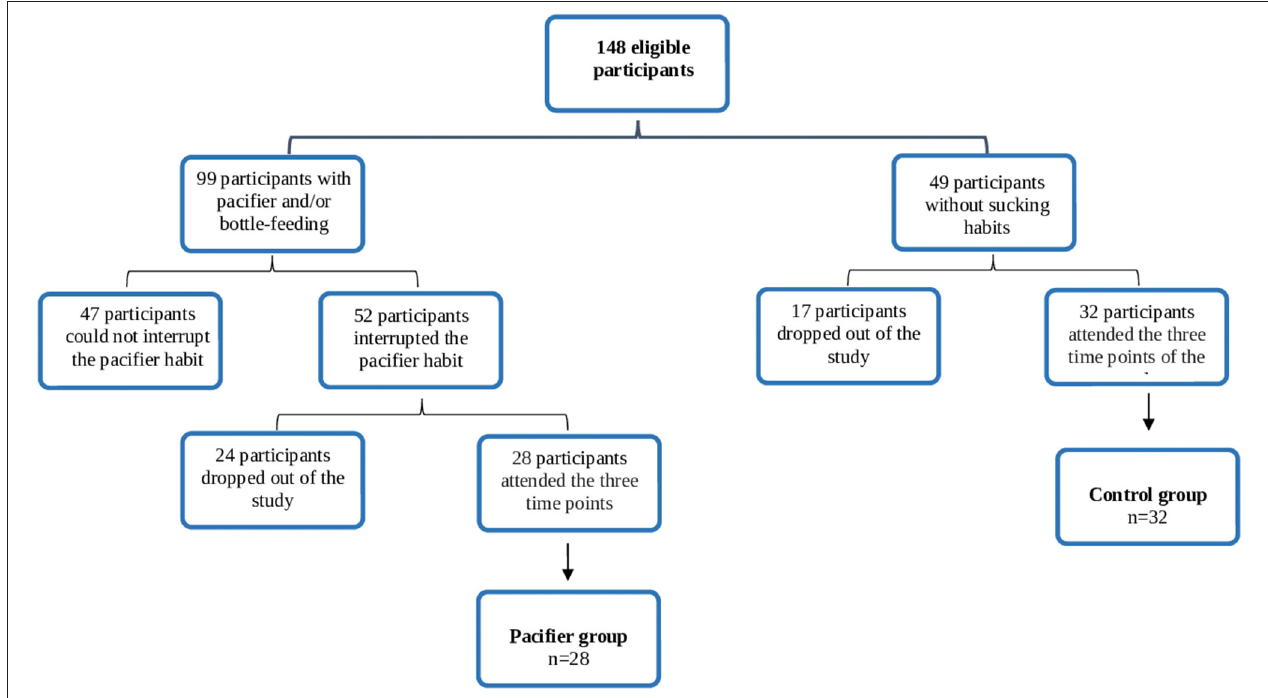
FIGURE 1 | Flowchart depicting the number of participants throughout the study and the final sample in each